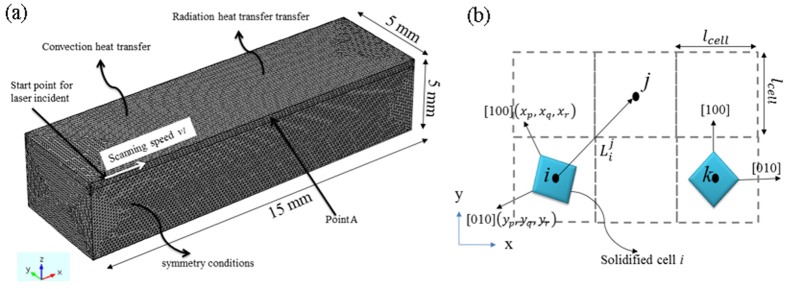
Detail of FE and CA simulations (a) Geometry and configuration of the simulated system. (b) Some concepts about CA model, two solidified grains i and k with different favorite orientation, the definition of (xp, xq, xr), (yp, yq, yr) and  in 2 dimensional.